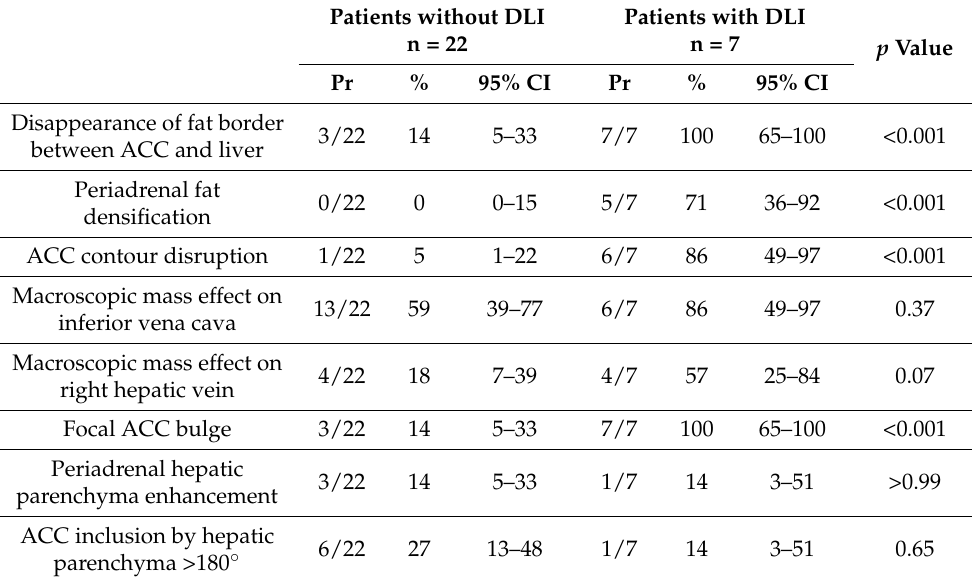
Table 5. Comparison of MRI findings for independent categorical criteria between 22 patients without DLI and 7 patients with